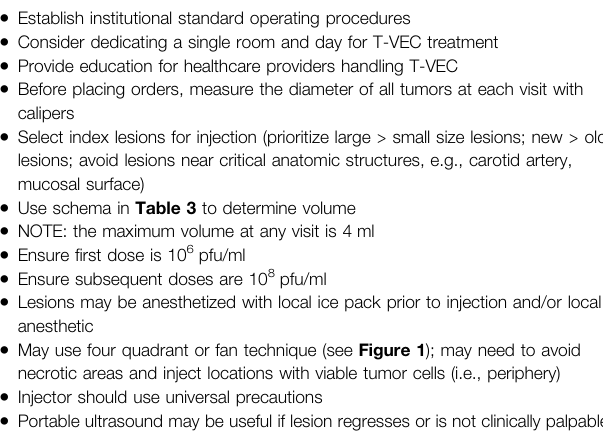
TABLE 2 | Considerations for treating patients with T-VEC in the ambulatory